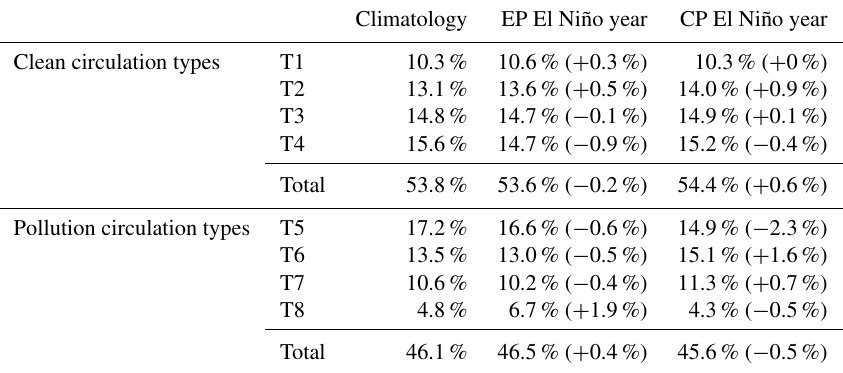
(Fig. S5e–h) over the JJJ region for circulation types 5,